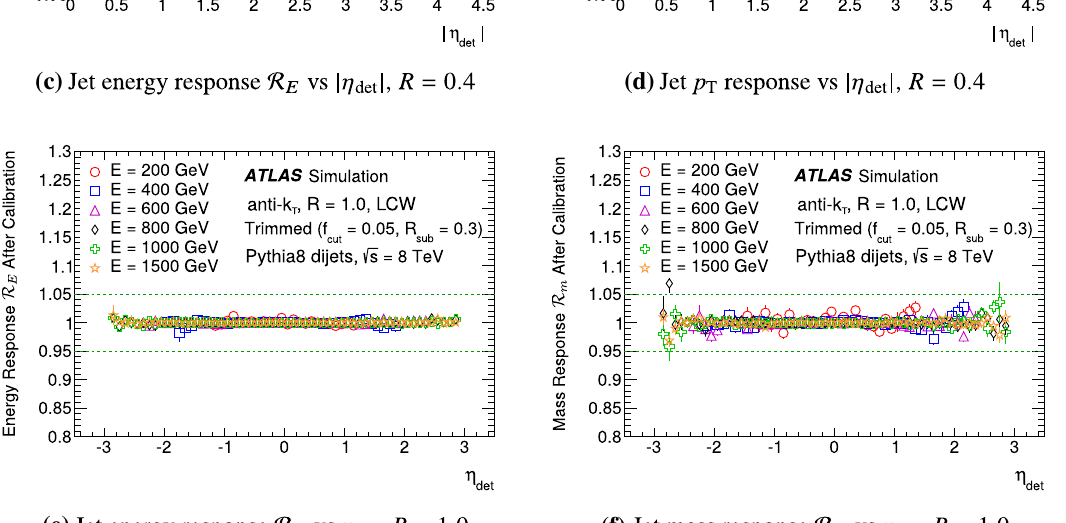
MC-based pseudorapidity calibration reported in Sect.